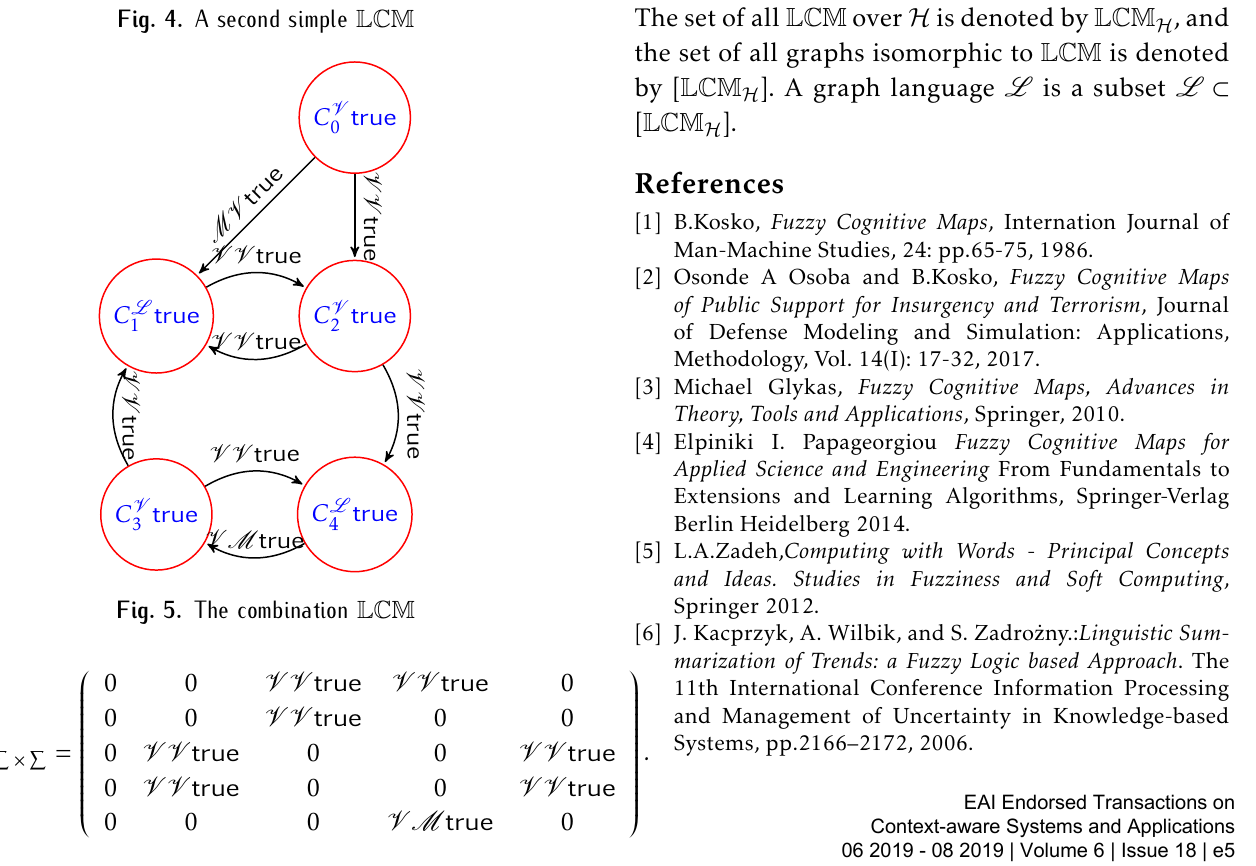
Fig. 4. A second simple LCM